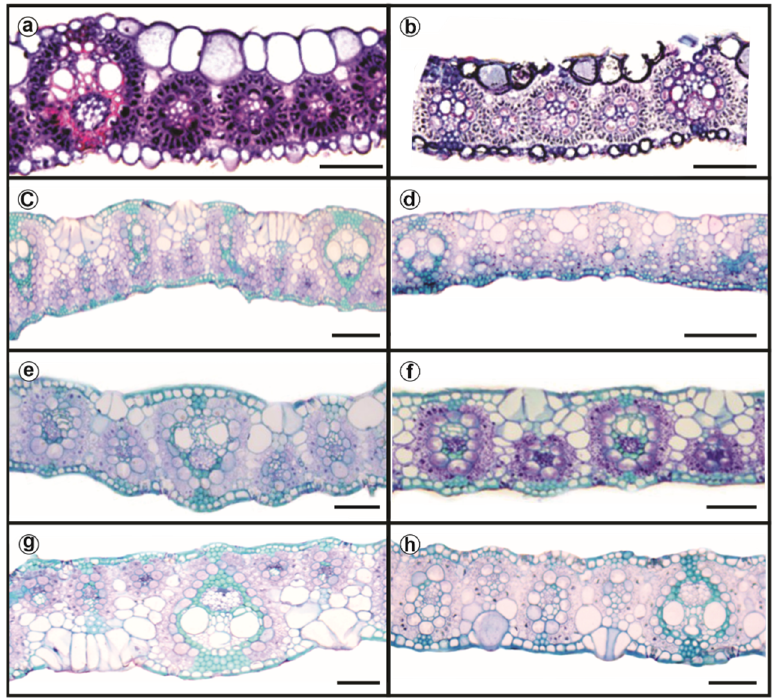
Figure 9. Light micrographs of cross-sections in four varieties (RB92579, ( a , b ); RB867515, ( c , d ); RB855536, ( e , f ); and RB72454, ( g , h )) of sugarcane. The leaf fragments were collected in rainy season ( a , c , e , g ) and dry season ( b , d , f , h ) at 8:00 to 10:00 h. Scale = ( a , b ), 20 μ m; ( c – h ), 50 μ m. For more information, see Table 3.